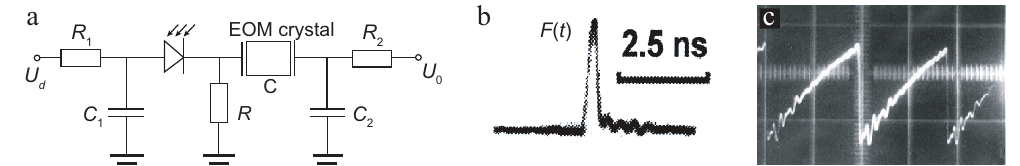
Figure 2. Electro-optical control circuit and signals: ( a ) equivalent circuit, U 0 is EOM 1 bias voltage, U d is photodiode bias voltage, R is a discharge resistor; ballast resistors R 1 and R 2 connect the voltage sources U d and U 0 to the circuit, C is EOM 1 capacity, C 1 and C 2 are capacitors such that C 1 (cid:29) C 2 , C 2 > C ; ( b ) photocurrent pulse; ( c ) EOM 1 control voltage, horizontal scale is 5 ns/div, vertical scale is 1 V/div which corresponds to the modulator control voltage of 250 V/div.